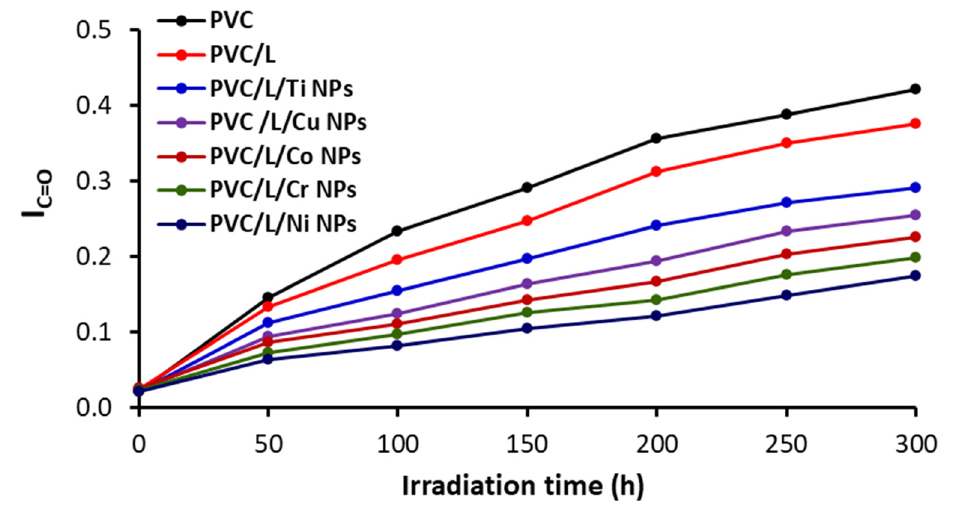
Figure 3. The I C=O index as a function of irradiation time for PVC films.